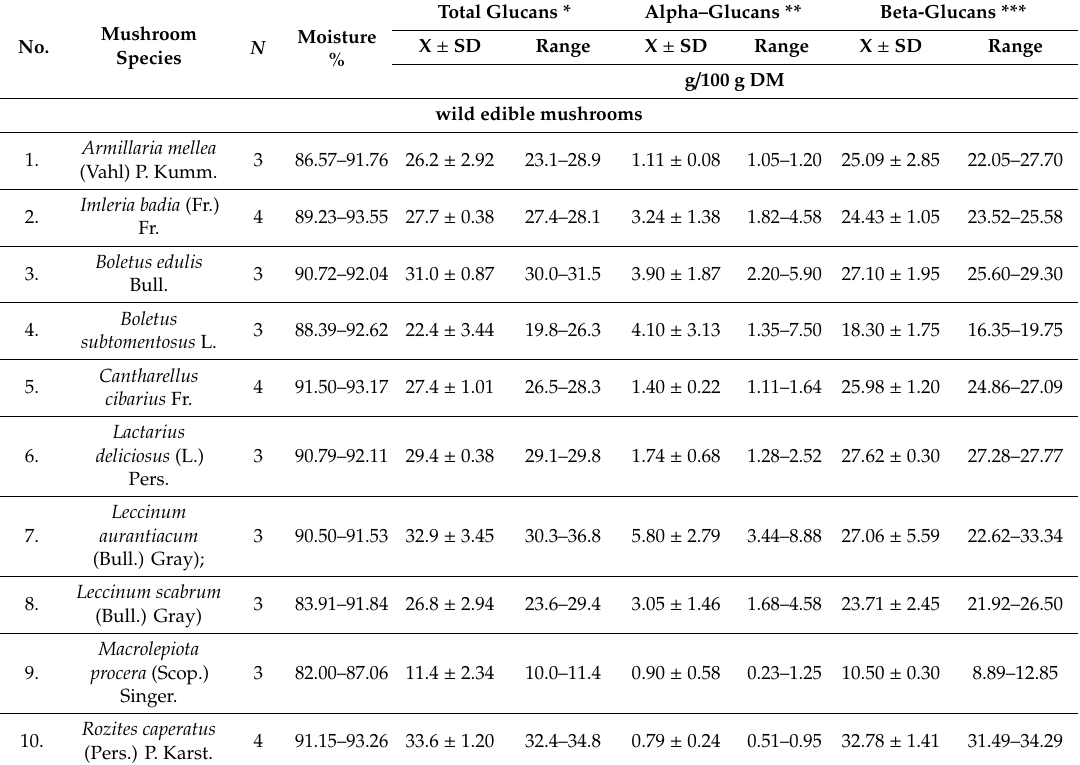
Table 1. Glucan (total glucans, alpha-glucans and beta-glucans) and moisture content in wild grown and commercial cultivated mushrooms, assayed with the Megazyme assay